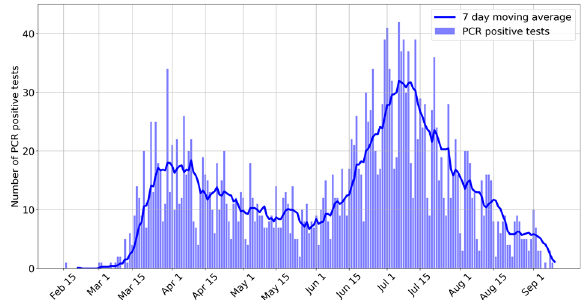
Fig. 4 Distribution of PCR positive tests. Distribution of the number of PCR positive tests per day in our survey, from February 16